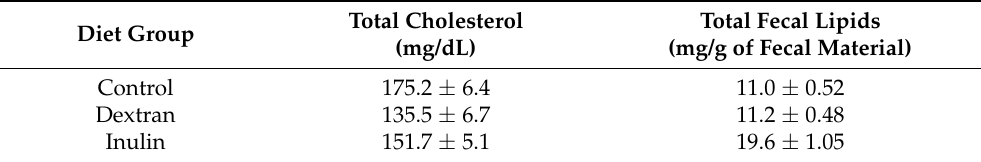
Table 1. Effect of dextran and inulin on total serum cholesterol and fecal lipid levels of